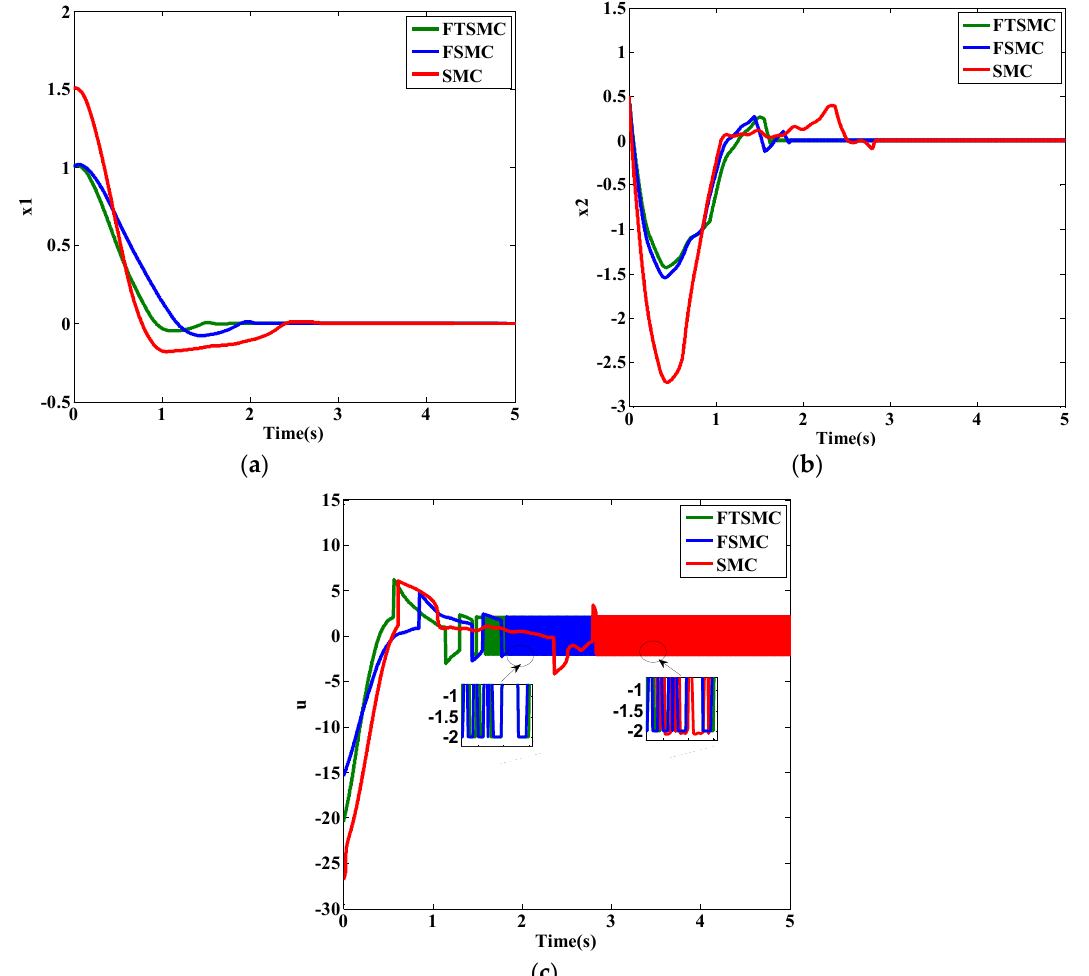
Figure 9. Sliding mode parameters of PMIWM. ( a ) State errors x 1 , ( b ) state errors x 2 , ( c ) control input U .